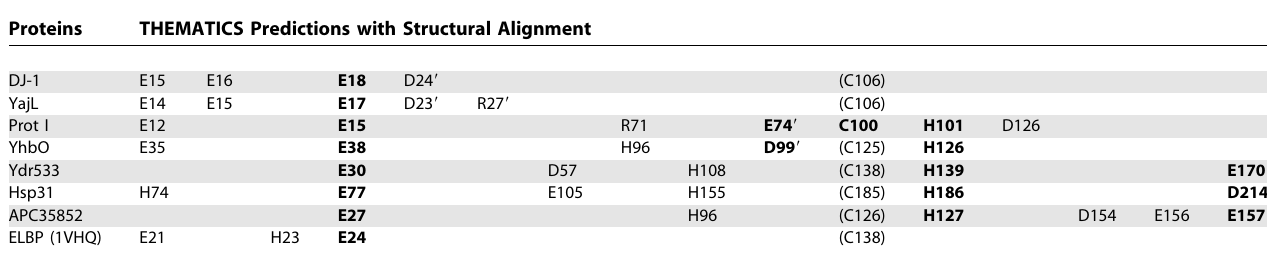
Table 2. Structurally Aligned THEMATICS Predictions for Six Proteins Proteins